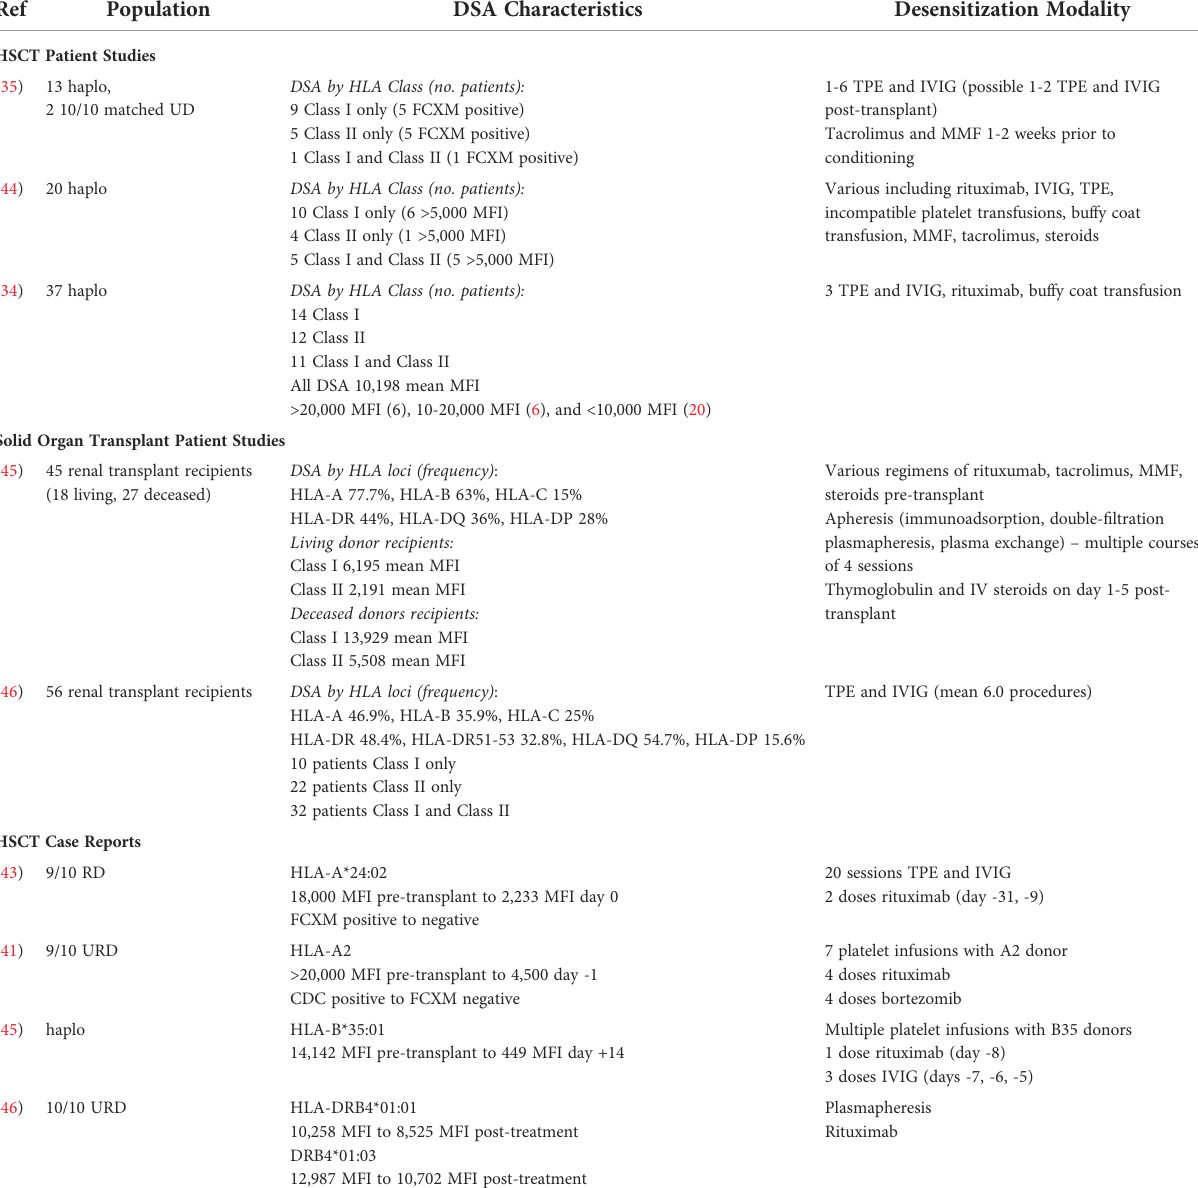
TABLE 3 Summary of DSA and desensitization methods used in HSCT and solid organ transplant studies. Ref Population DSA Characteristics Desensitization